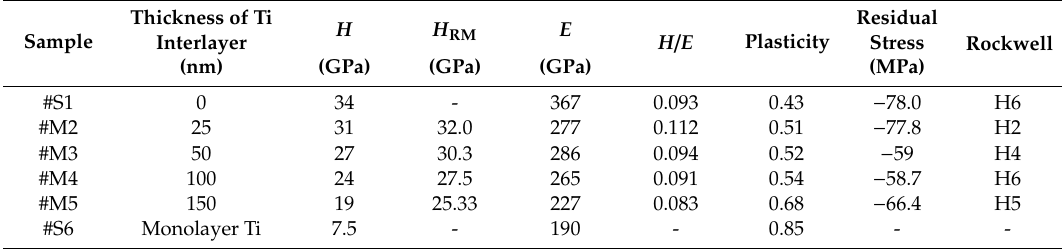
Table 1. Thickness of Ti interlayer and mechanical properties of all the